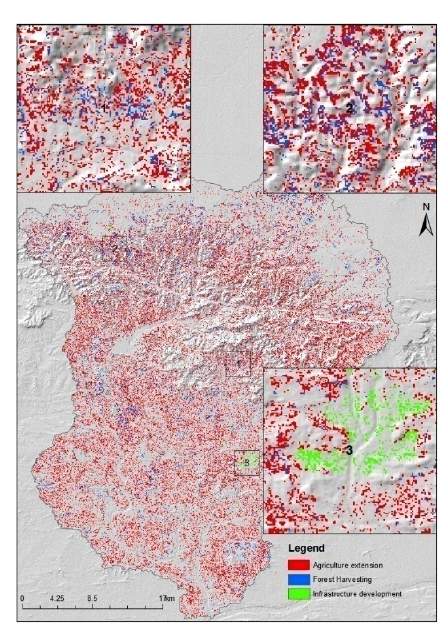
Figure 5. Mapped deforestation and forest degradation associate with responsible driver using GIS based direct interpretation approach (2009–2013)